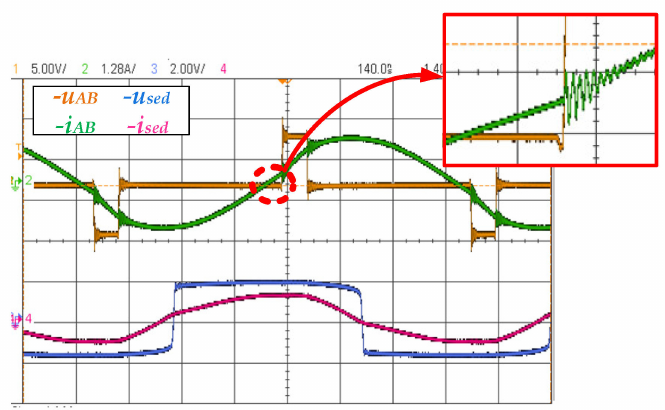
Figure 24. Waveforms of the current and voltage on the primary and secondary sides when the MOSFETs work in hard-switching state.